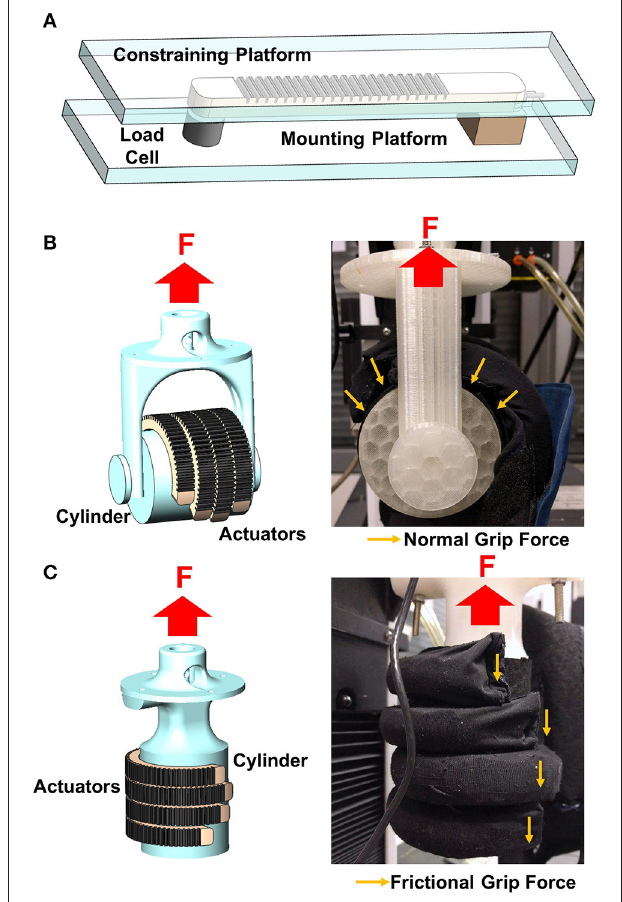
FIGURE 2 | Schematic of the force measurement system for (A) blocked tip force, (B) normal grip force, and (C) frictional grip force